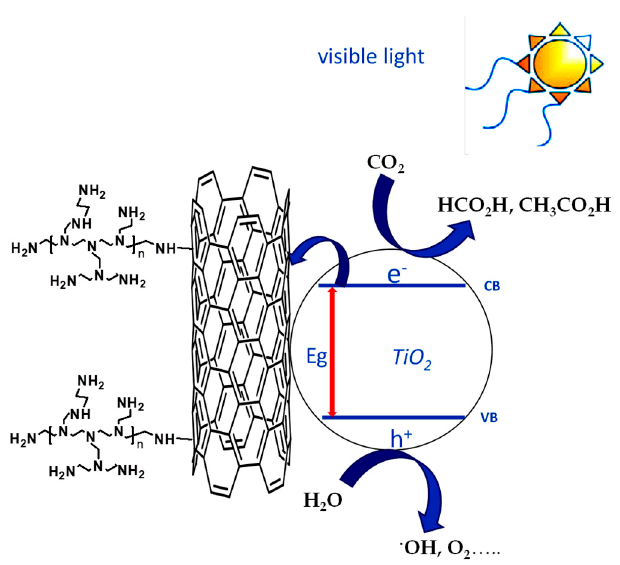
Figure 10. Effect of PEI conjugation on separation of photogenerated electron–hole pairs for TiO @PEI-MWCNTs nanocomposite. 2